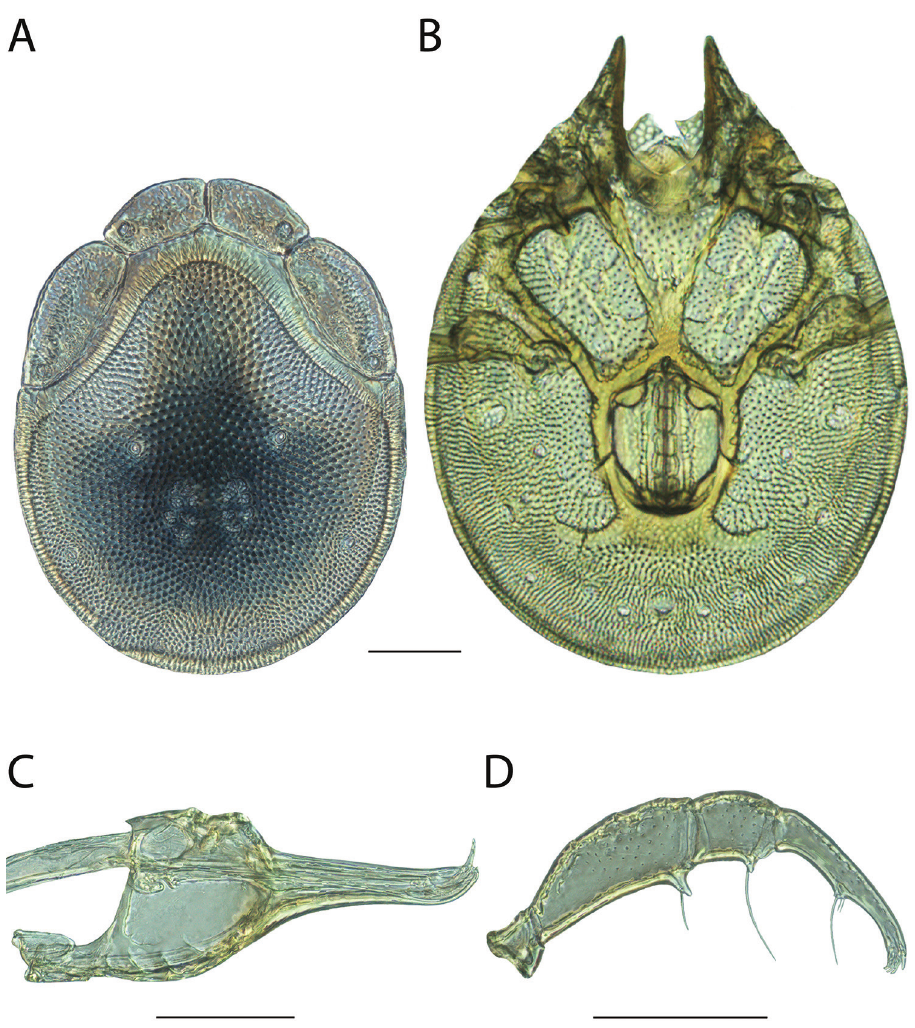
Figure 133. Torrenticola longitibia sp. n. male: A dorsal plates B venter (legs removed) C subcapitulum D pedipalp (setae not accurately depicted). Scale = 100